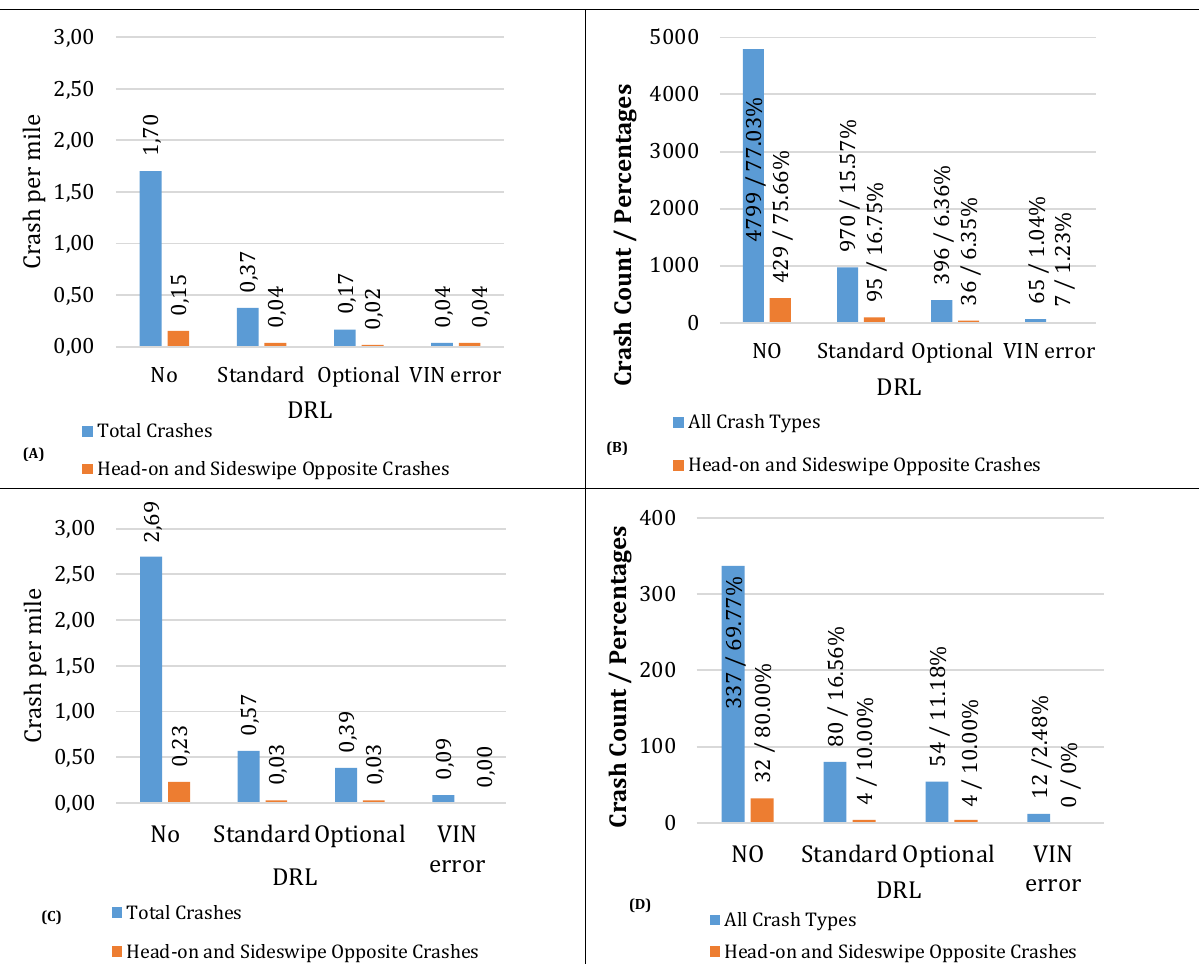
Figure 3: Rates, frequencies and percentages of total and target